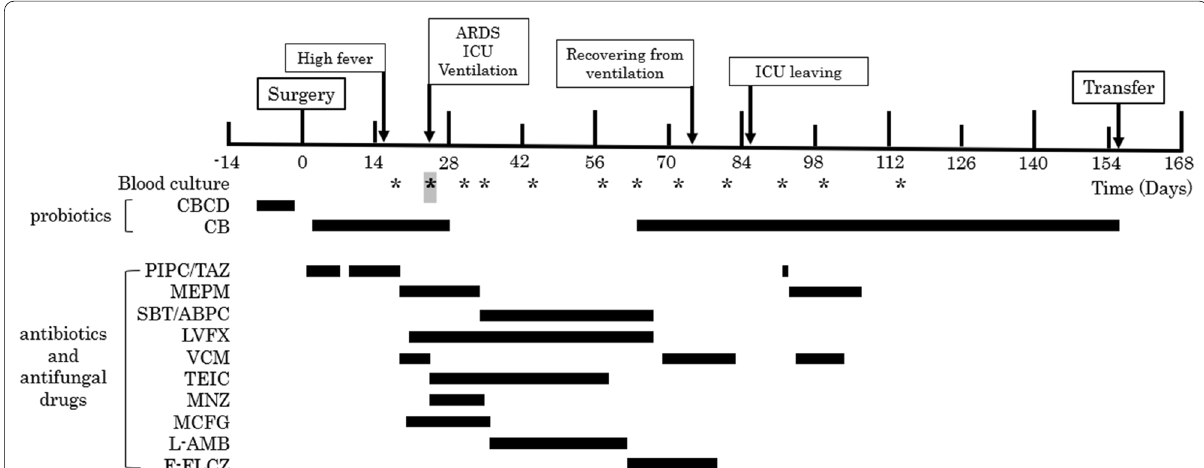
Fig. 5 Postoperative course of case 2. Asterisks indicate blood culture tests. A bold asterisk highlighted in gray indicates positive blood culture of Clostridium butyricum . ARDS, acute respiratory distress syndrome; C. butyricum , Clostridium butyricum ; CBCD, Clostridium butyricum combined drug; F-FLCZ, fosfluconazole; ICU, intensive care unit; L-AMB, amphotericin B (liposomal); LVFX, levofloxacin; MCFG, micafungin; MEPM, meropenem; MNZ, metronidazole; PIPC/TAZ, piperacillin/tazobactam; SBT/ABPC, sulbactam/ampicillin; TEIC, teicoplanin; VCM, vancomycin hydrochloride